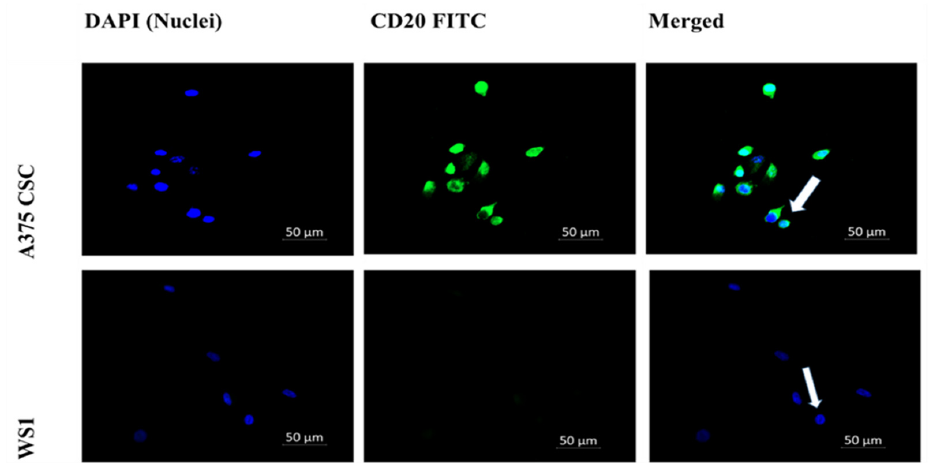
Figure 2. Cell-surface antigenic marker CD20 immunofluorescence microscopy (200× magnification): A375 CSCs expressing CD20 when directly labeled with FITC-conjugated CD20 (green) and counterstained with DAPI (blue) marked with white arrows. The WS1 negative control showed no expression.